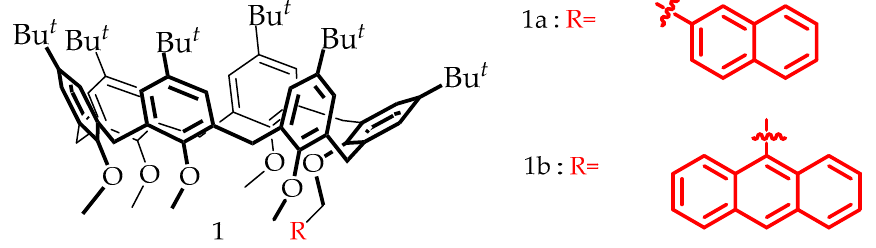
Figure 2. Calix[6]arene hosts 1a and 1b with fluorophores covalently